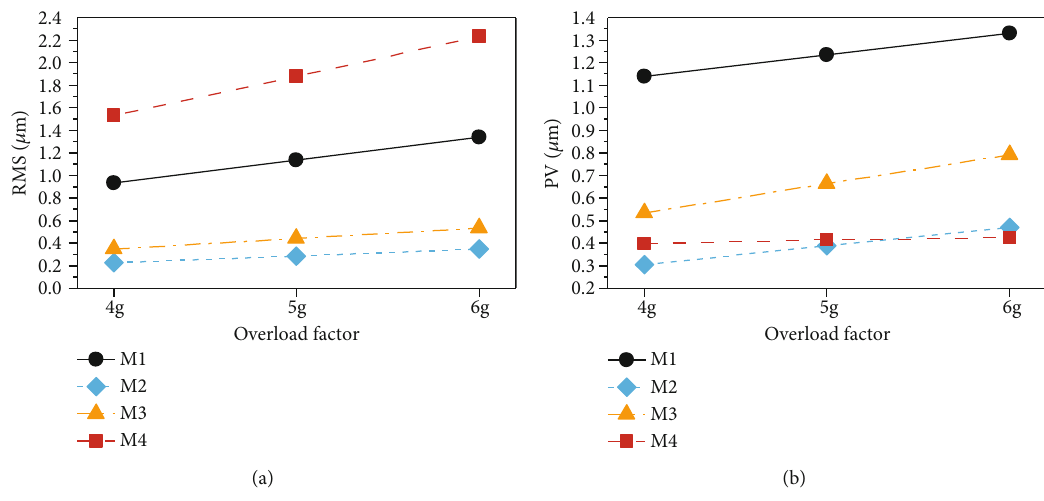
Figure 9: RMS value and PV value: (a) RMS value; (b) PV